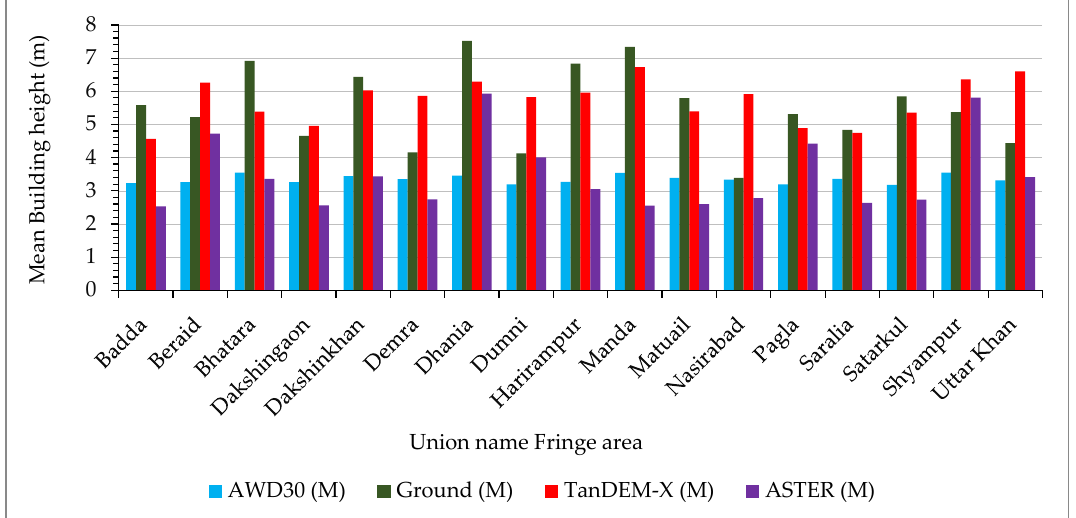
Figure 9. Union-wise (small administrative boundary) mean building height of the fringe area.